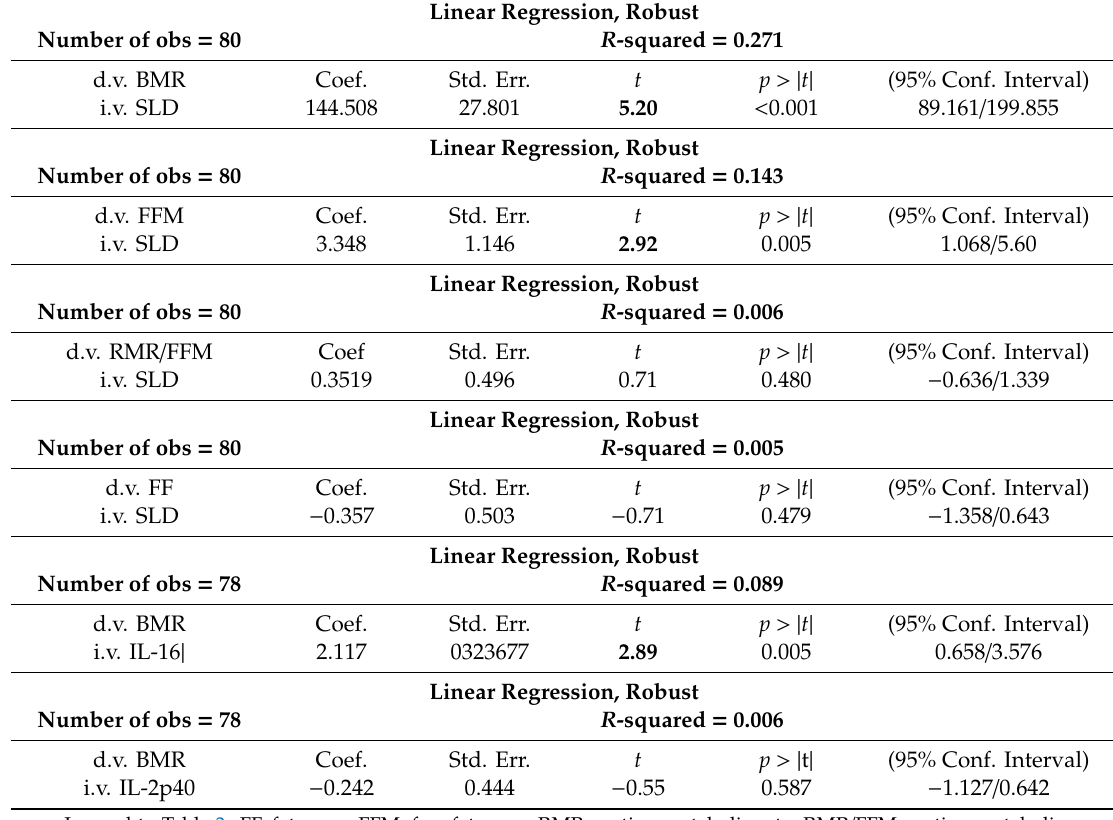
Table 3. Prediction of indices of indirect calorimetry by spleen longitude diameter (SLD). Prediction of basal metabolic rate (BMR) by IL-6 and IL-12p40 levels. Linear Regression, Robust